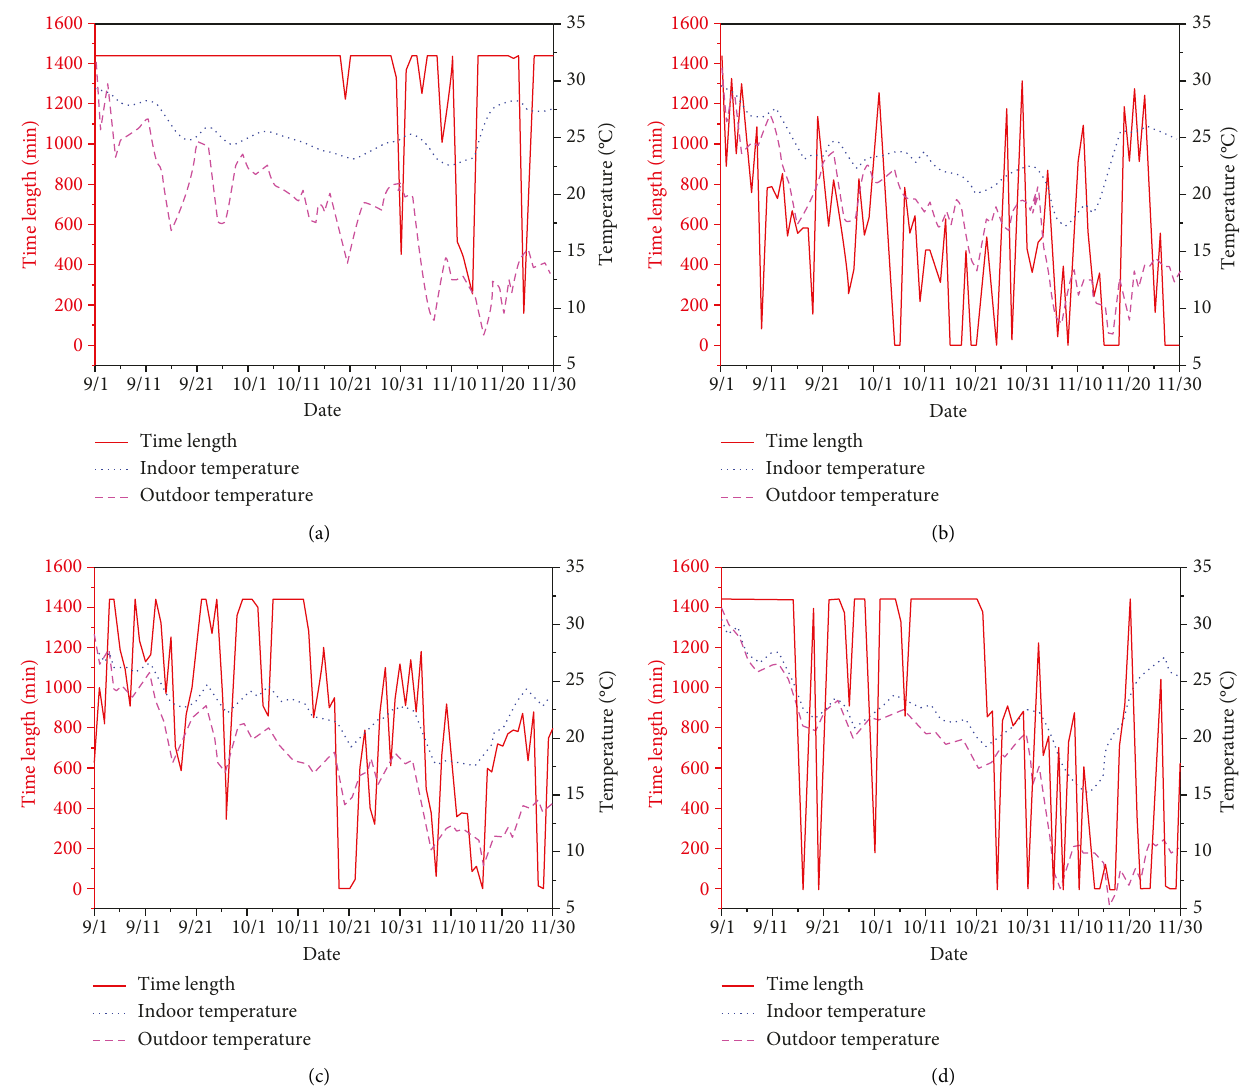
Figure 6: Window opening times and indoor and outdoor temperatures for the four residences: (a) residence #1, (b) residence #2, (c) residence #3, and (d) residence